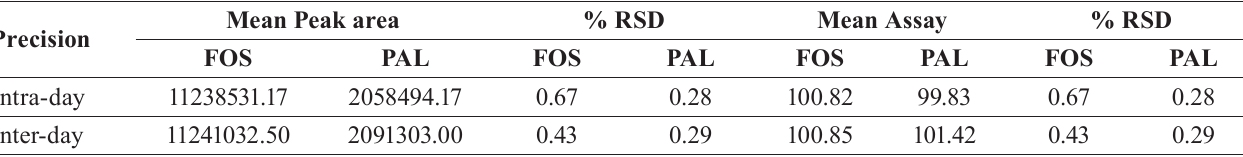
TABLE V - P recision study Precision